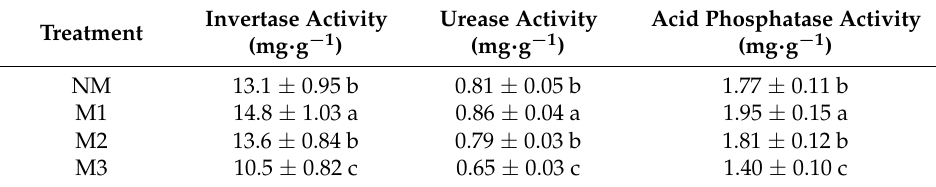
Table 3. Selected enzyme activity of soil in P. edulis stands of different mulching years. Treatment